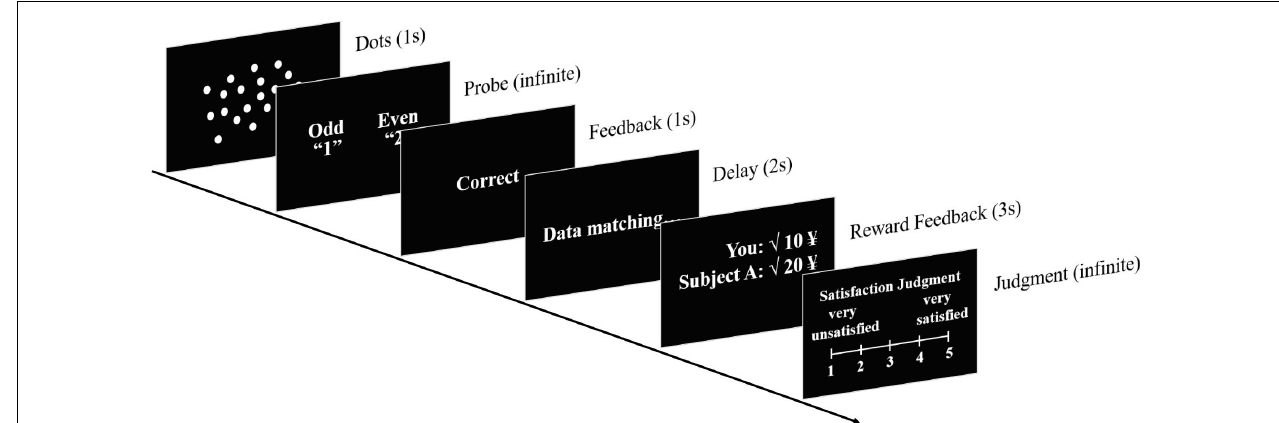
FIGURE 1 | A sequence of events in a single